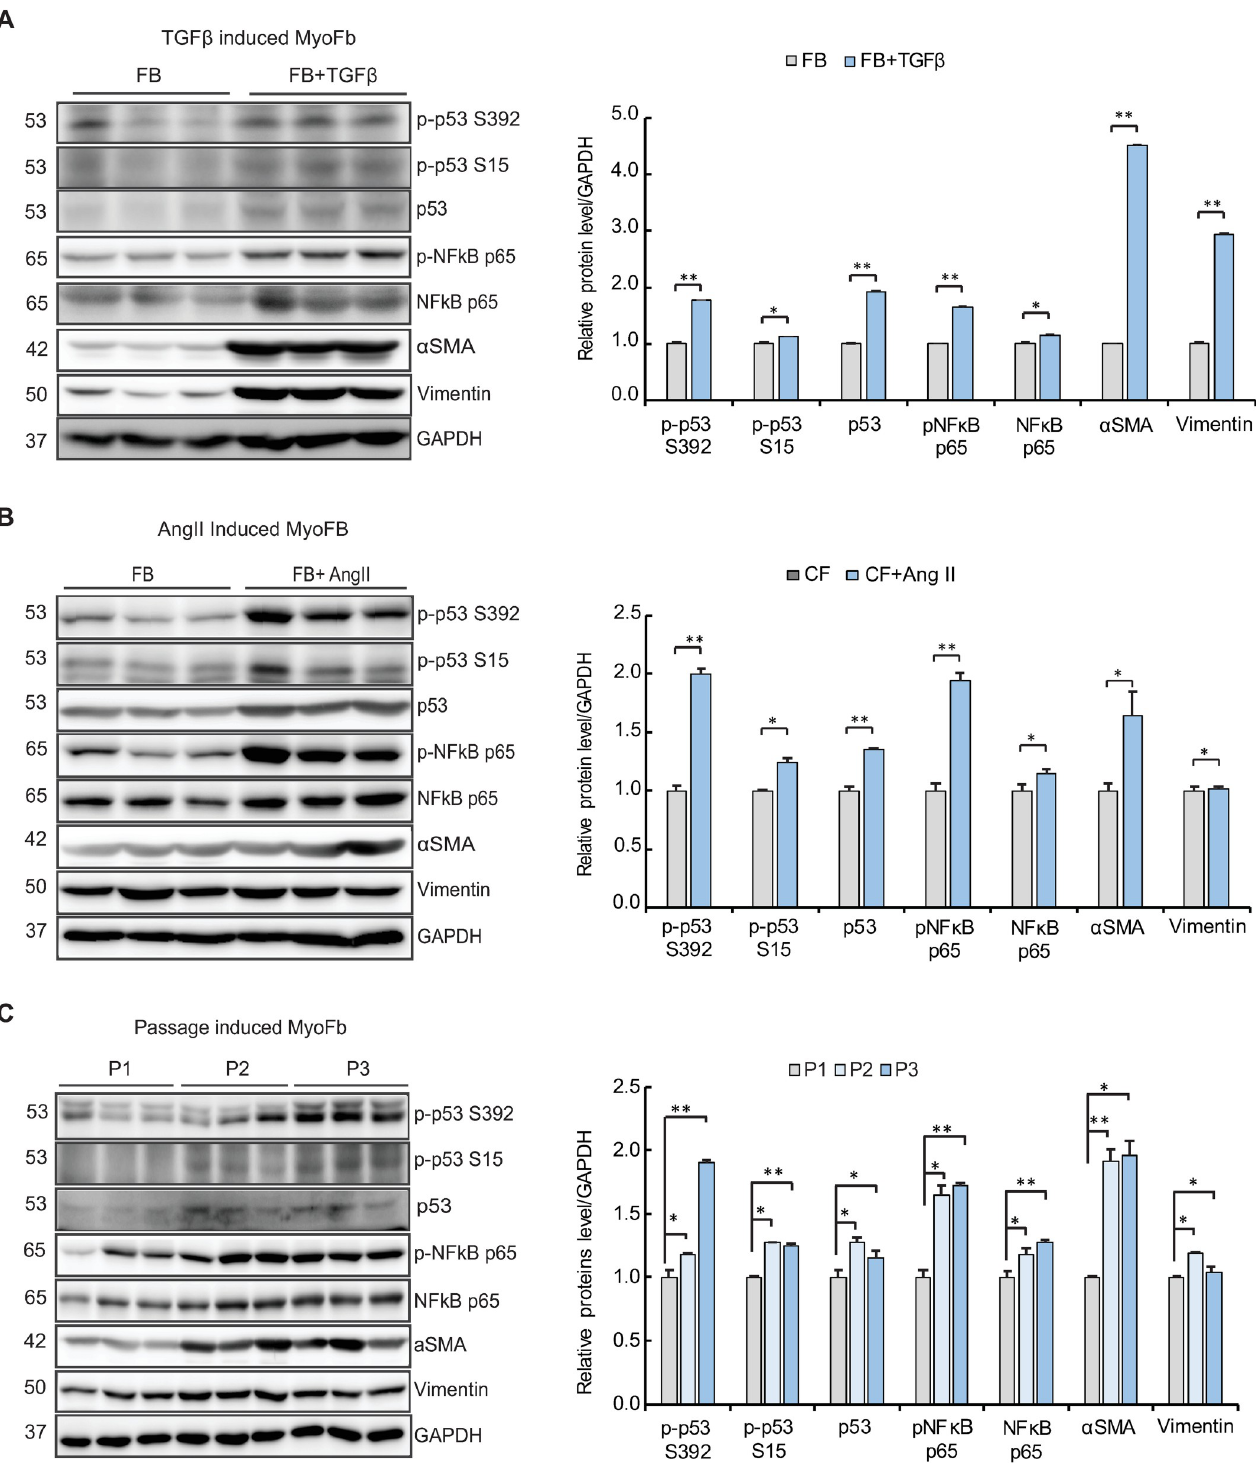
Fig 1. The p53 and NF κ B signaling pathways are up-regulated in MyoFBs. Freshly prepared FBs were treated with (A) 10 ng/mL TGF- β or (B) 100 nM AngII, or (C) were subcultured. Cells lysates were then used for western blotting analysis. The expression levels of p53, phosphorylated p53 (p-p53 S15 or p-p53 S392), NF κ B p65, phosphorylated NF κ B p65 (p-NF κ B p65), vimentin, and α -smooth muscle actin ( α -SMA) were monitored by western blotting. GAPDH was used as a loading control. For each group, three independent cultures were prepared and treated (n = 3).